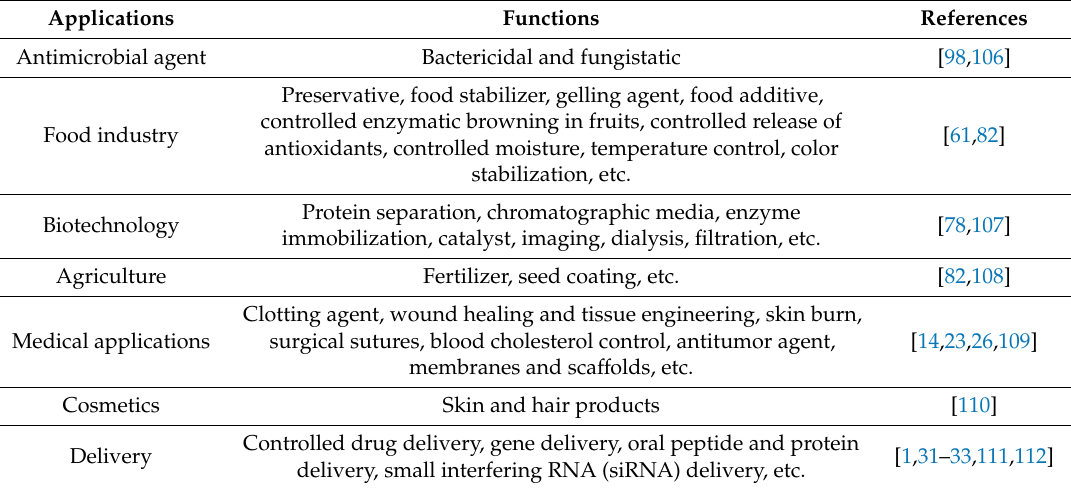
Table 1. Field of application potentials of chitosan (Ch) and its derivatives